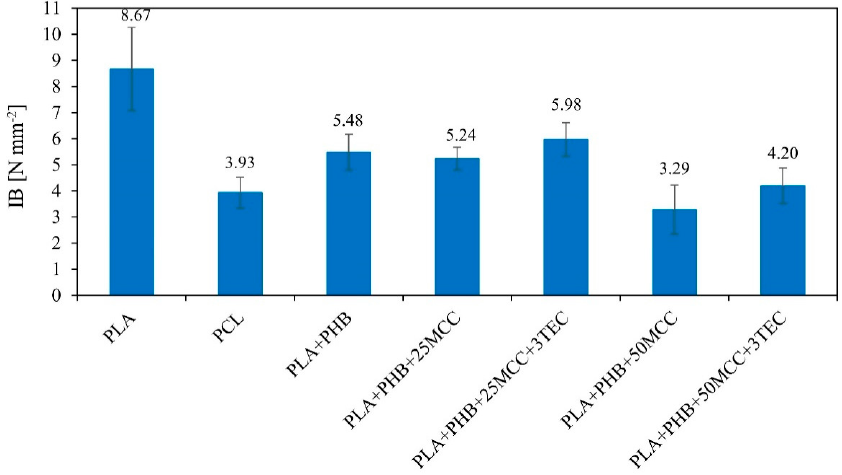
Figure 6. Internal bond (IB) results of tested five-layer composites.